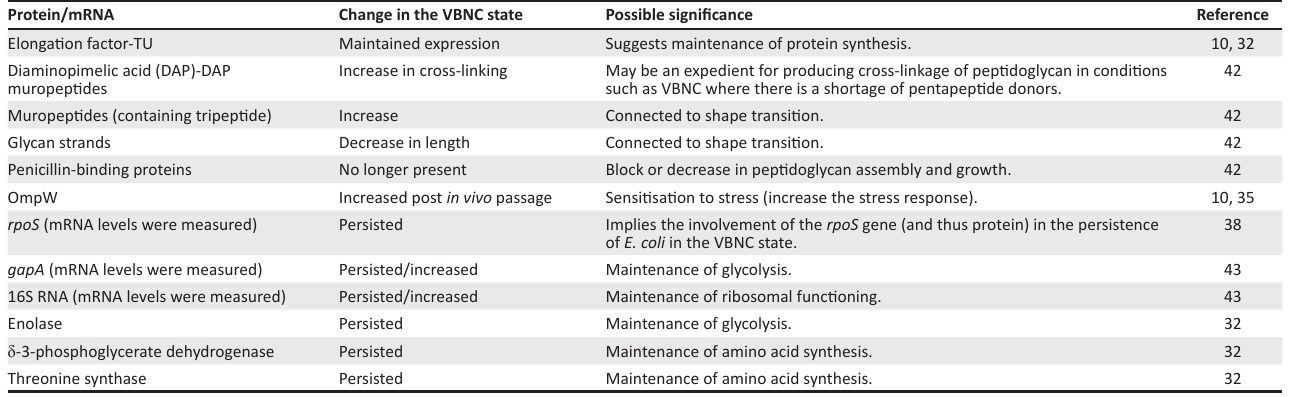
TABLE 2: Reported proteomic changes in the viable but non-culturable state in Escherichia coli . Protein/mRNA